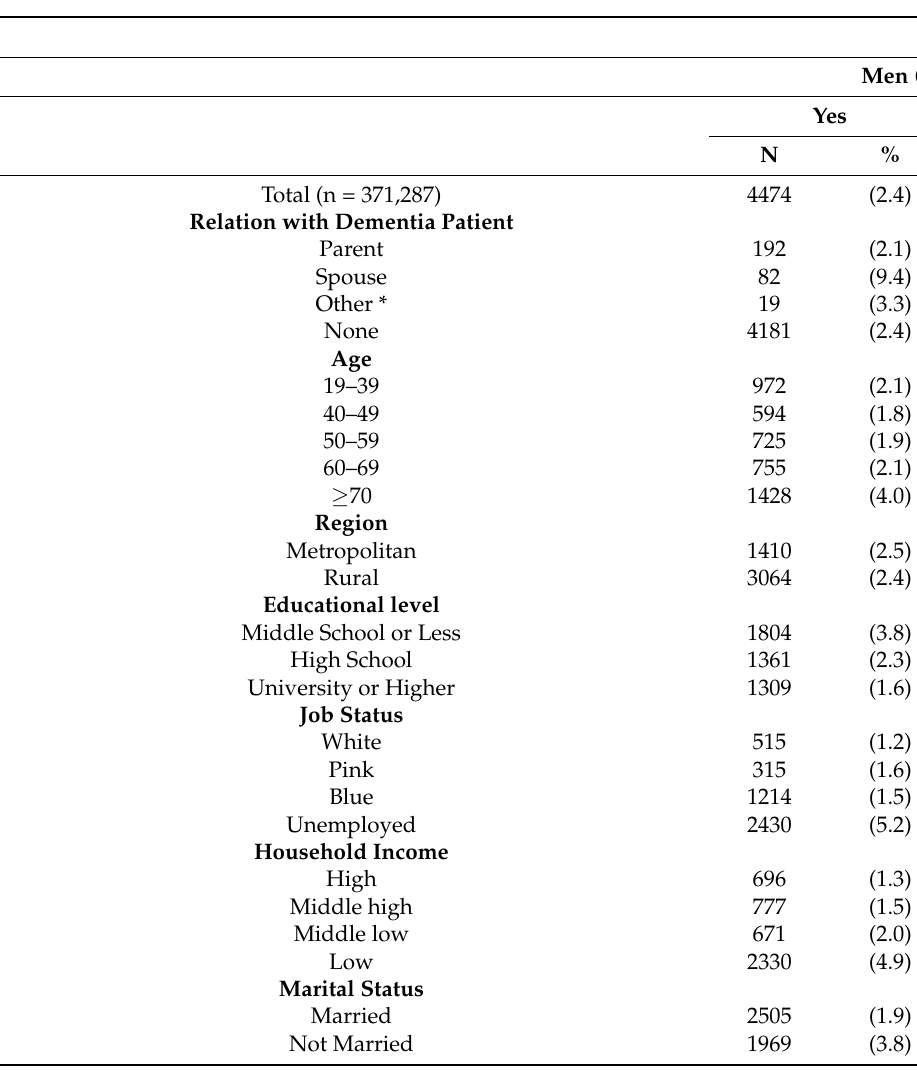
Table 1. General characteristics of study